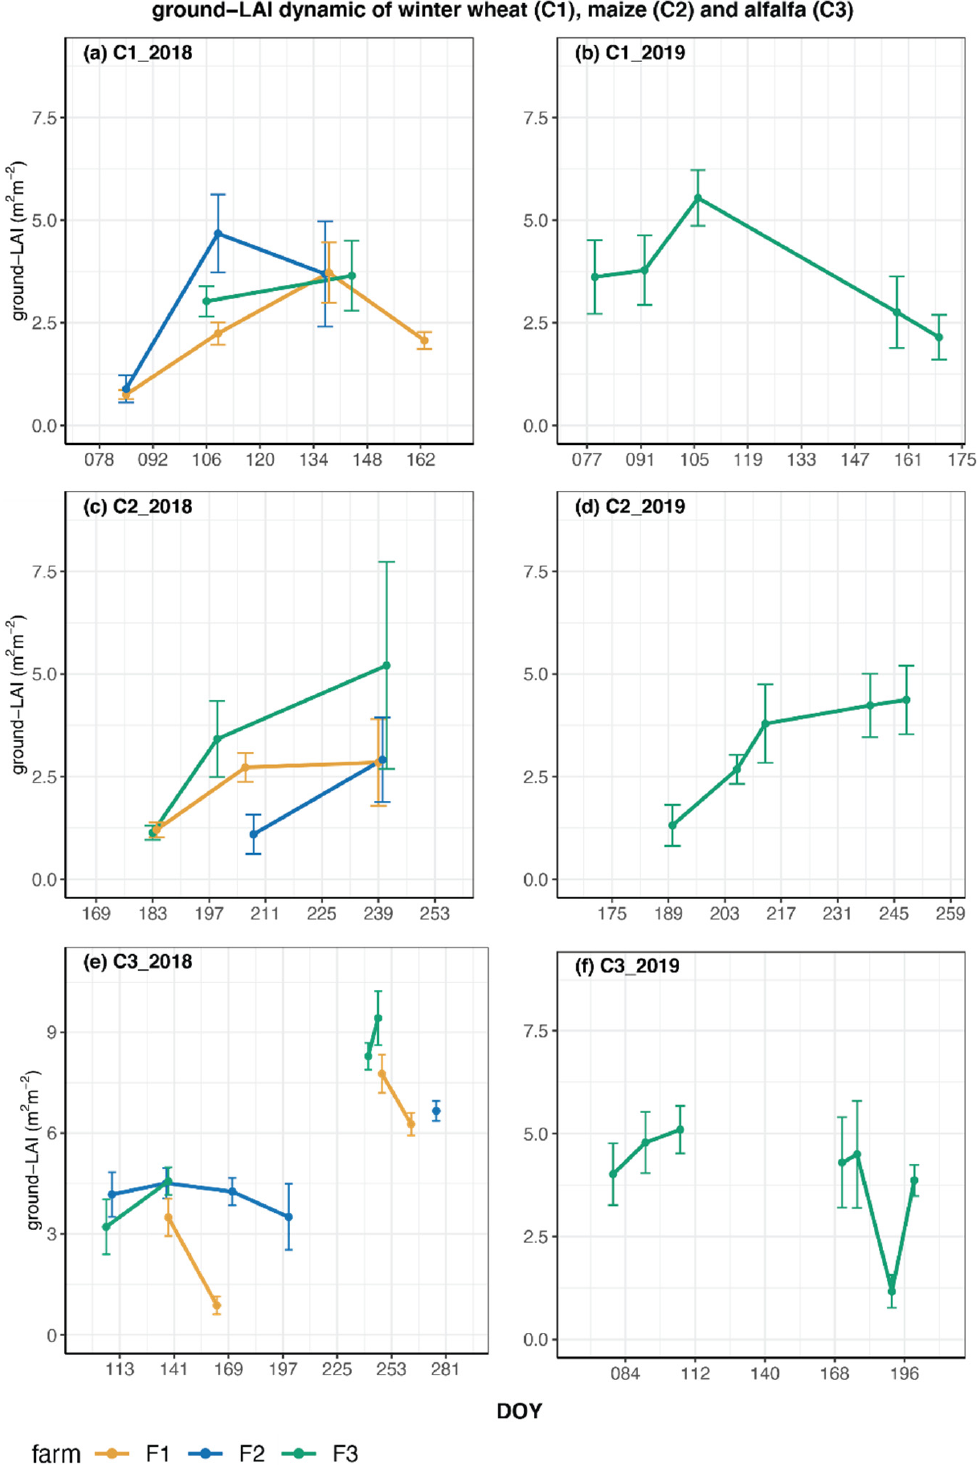
Figure 3. Mean values of the measured ground-LAI values of winter wheat (C1), maize (C2), and alfalfa (C3), according to the main crop development stages. The growing stages for winter wheat and maize are: SE, stem elongation; Fl, flowering; and FD, fruit development. For alfalfa, the growing stages are: Vg, vegetative; Fl,